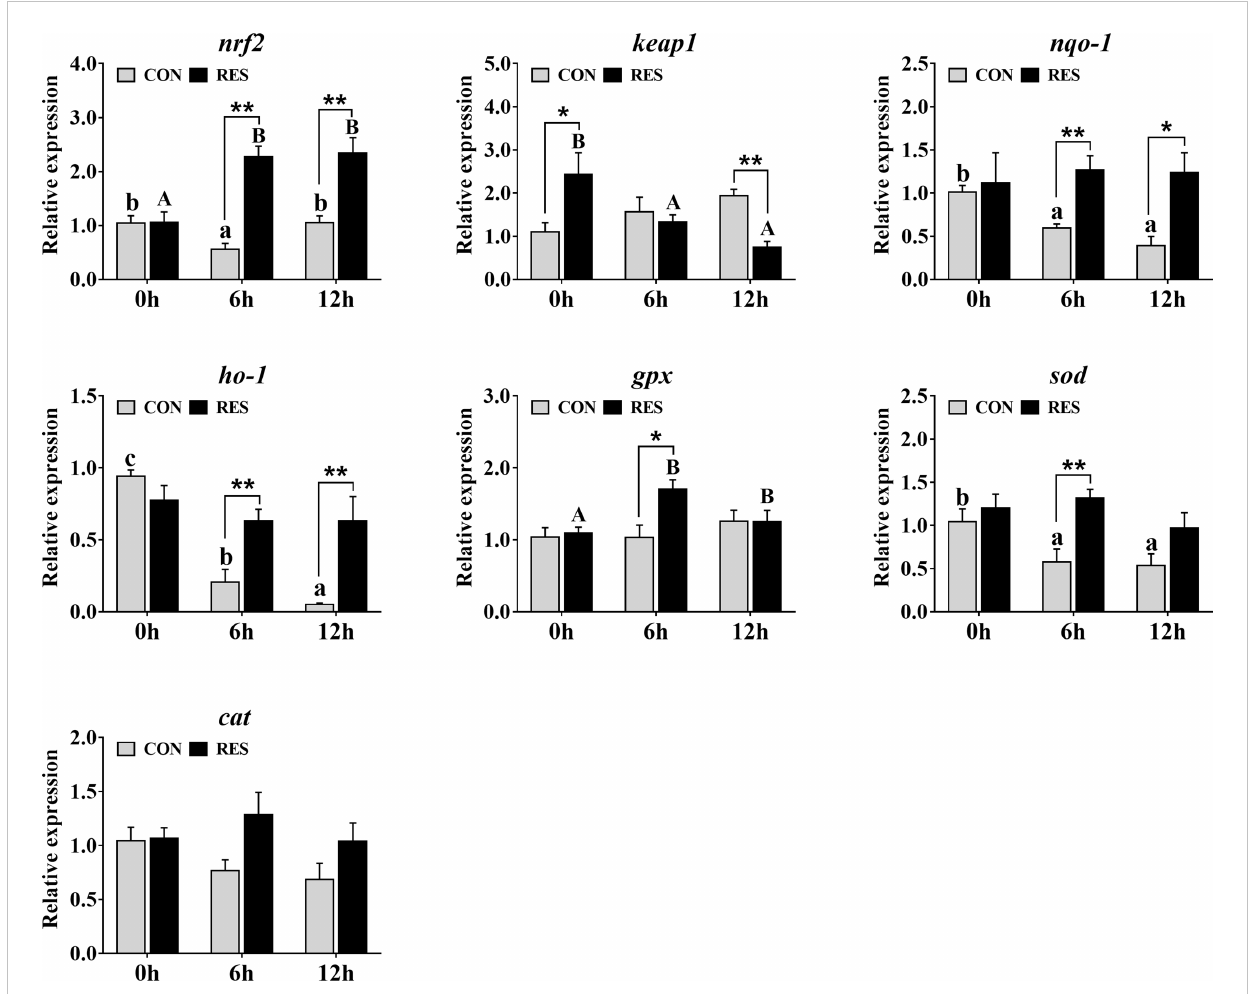
FIGURE 5 Effect of dietary RES on mRNA expression levels of antioxidant-related genes in the liver of gibel carp at 6 h and 12 h after LPS injection. The lowercase letters represent the signi fi cant differences among diverse LPS durations in the CON group ( P < 0.05); the uppercase letters represent the signi fi cant differences among diverse LPS durations in the RES group ( P < 0.05). *( P < 0.05) and **( P < 0.01) represent signi fi cant differences between the CON and RES groups. Nrf2 : nuclear factor [erythroid-derived 2]-like 2; keap1 : kelch-like ECH-associated protein-1; nqo-1 , NADPH quinine oxidoreductase-1; ho-1 , heme oxygenase-1; gpx , glutathione peroxidase; sod , superoxide dismutase; cat ,